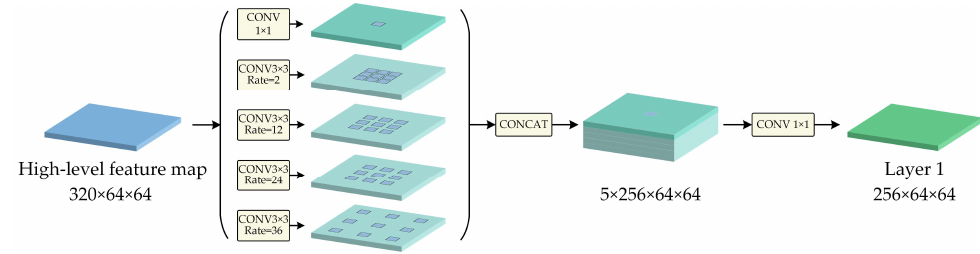
Figure 4. Schematic diagram of the ASPP module. The ASPP module concatenates and fuses five feature maps to obtain multiscale feature map features.